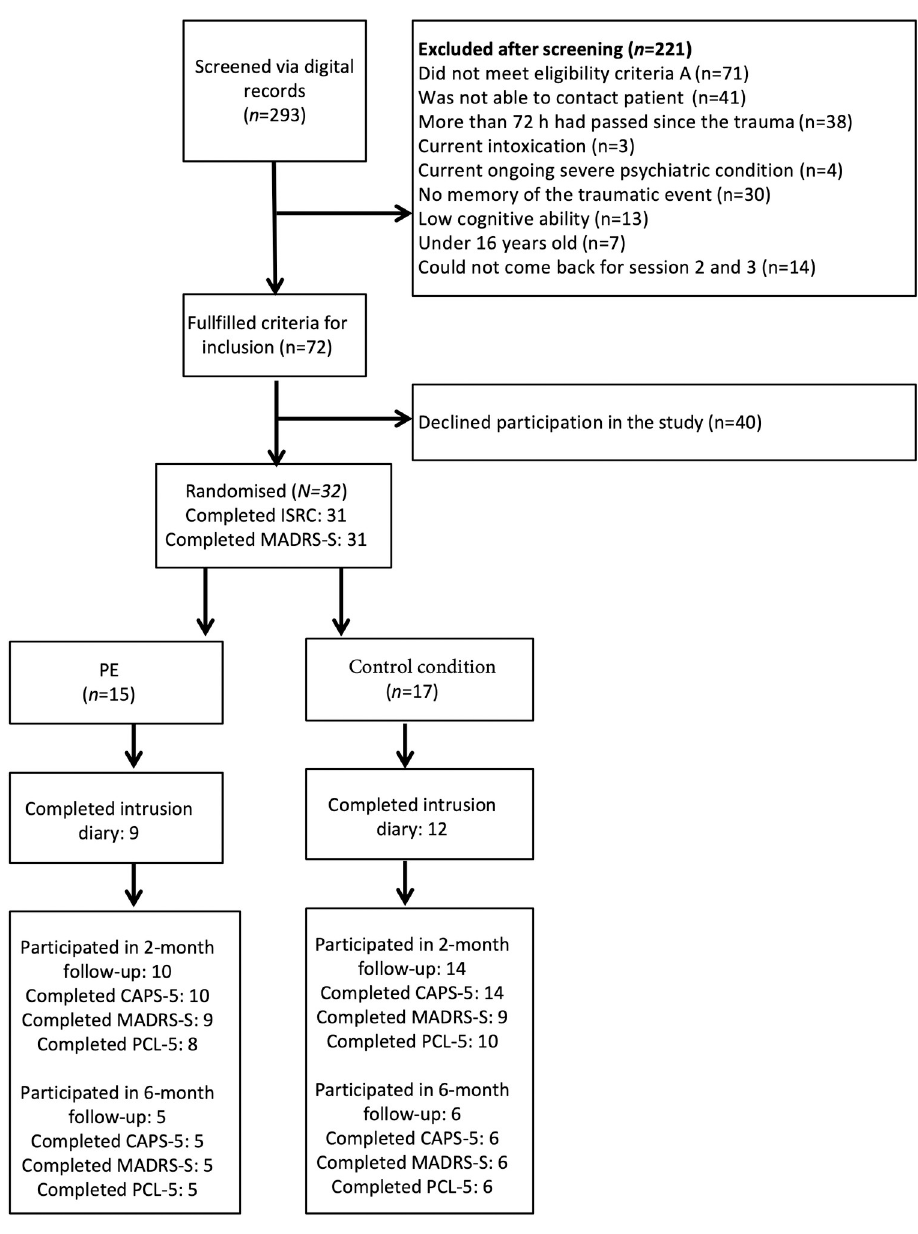
Fig 2. Participant flow